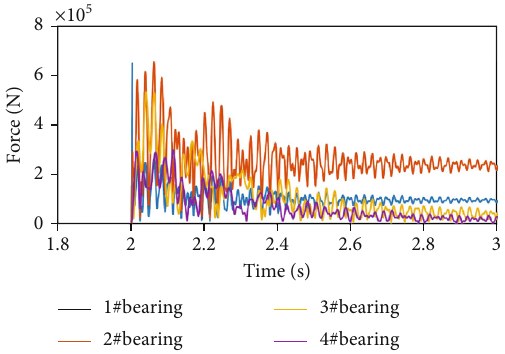
Figure 18: Reaction force of the rotor system with a variable- sti ff ness fusing structure.